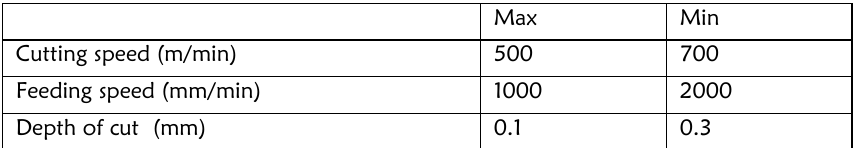
Table 1: Machining levels.